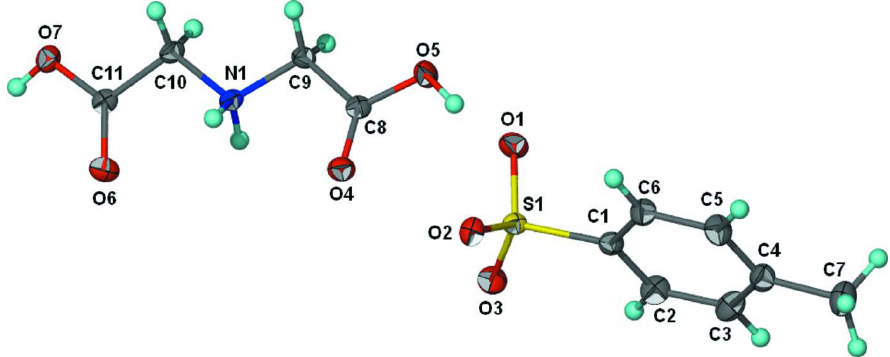
H NO ) + (C H O S) - at the 70% probability level. Hydrogen atoms are drawn 4 8 4 7 7 3